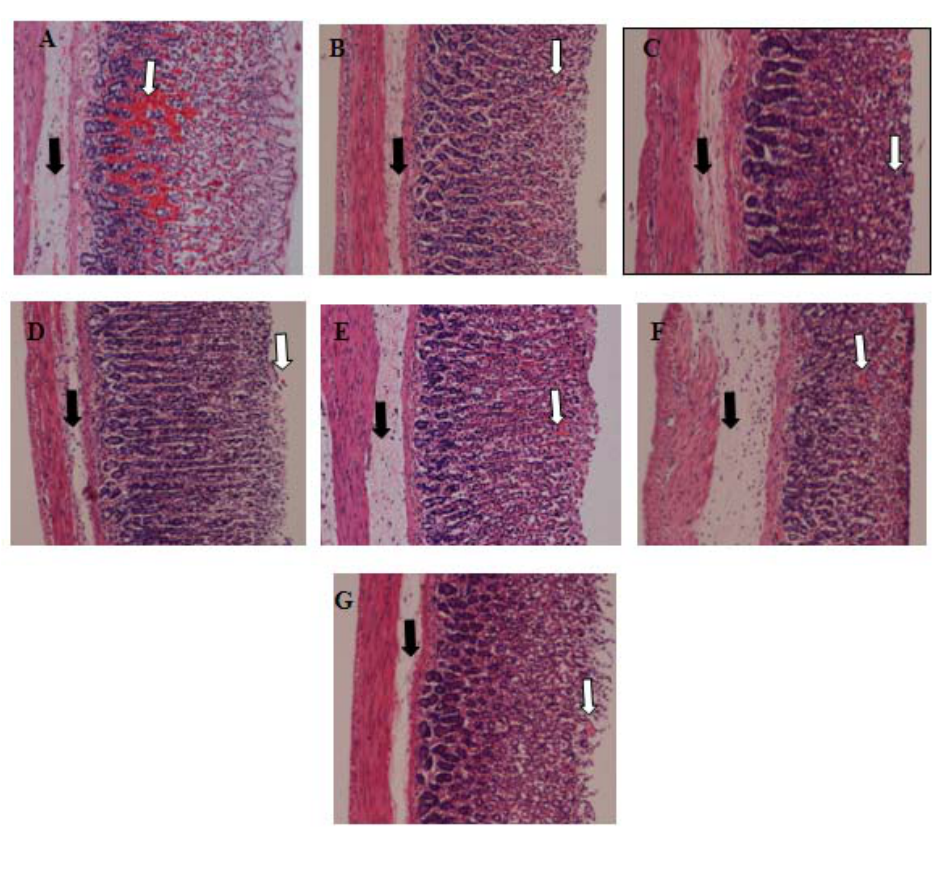
Figure 3. ( A ) Histological evaluation of the gastric mucosa of rats pre-treated with CMC (ulcer control group); ( B ) Omeprazole, 20 mg/kg (positive control group); ( C ) F1 100 mg/kg; ( D ) F2 100 mg/kg; ( E ) F3 100 mg/kg; ( F ) F4 100 mg/kg; ( G ) F5 100 mg/kg. White arrows represent severe disruptions to the surface epithelium and deep mucosa, while black arrows represent leukocyte infiltration and edema in the submucosal layer (H & E stain;